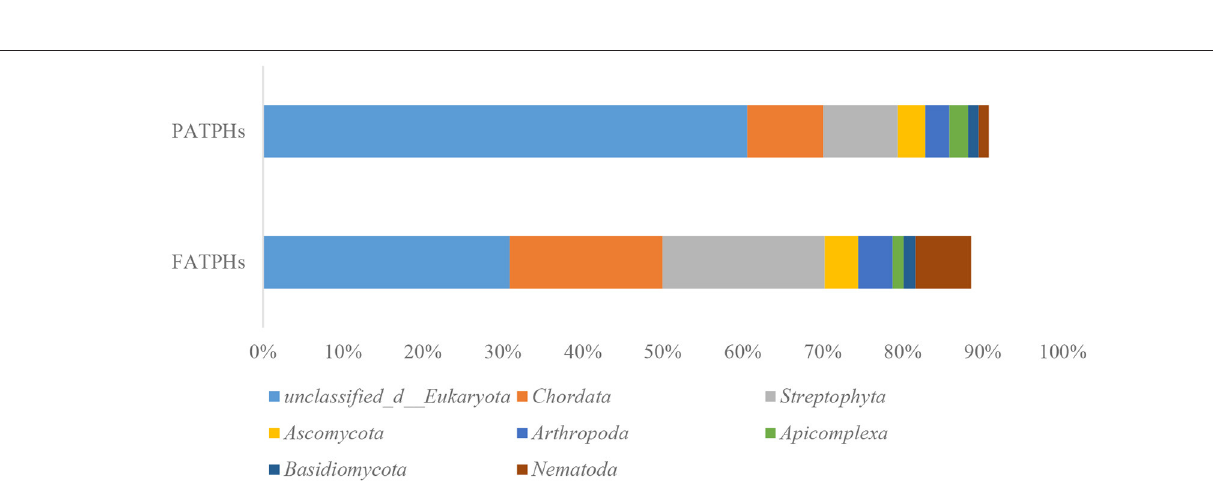
FIGURE 5 | Relative abundances of top four bacterial species in PATPHs and their corresponding species in FATPHs.